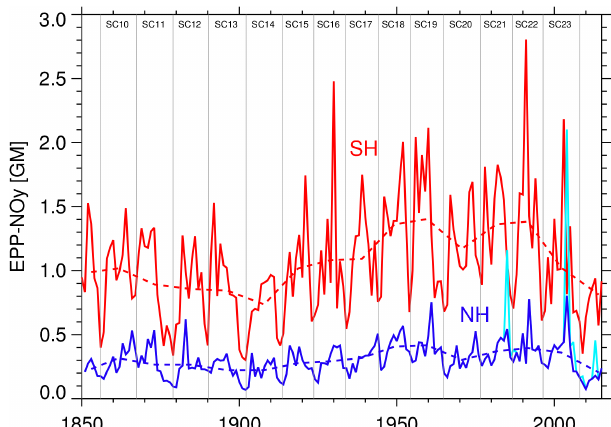
Figure 13. Reconstructed stratospheric EPP-NO y deposition below 0.5hPa ( ∼ 50km) in the SH (red) and NH (without ES events, dark blue) during 1850–2015. NH depositions with consideration of ES events (only 1979–2014) are shown with the light blue line. Solar cycle average depositions are indicated with the dashed